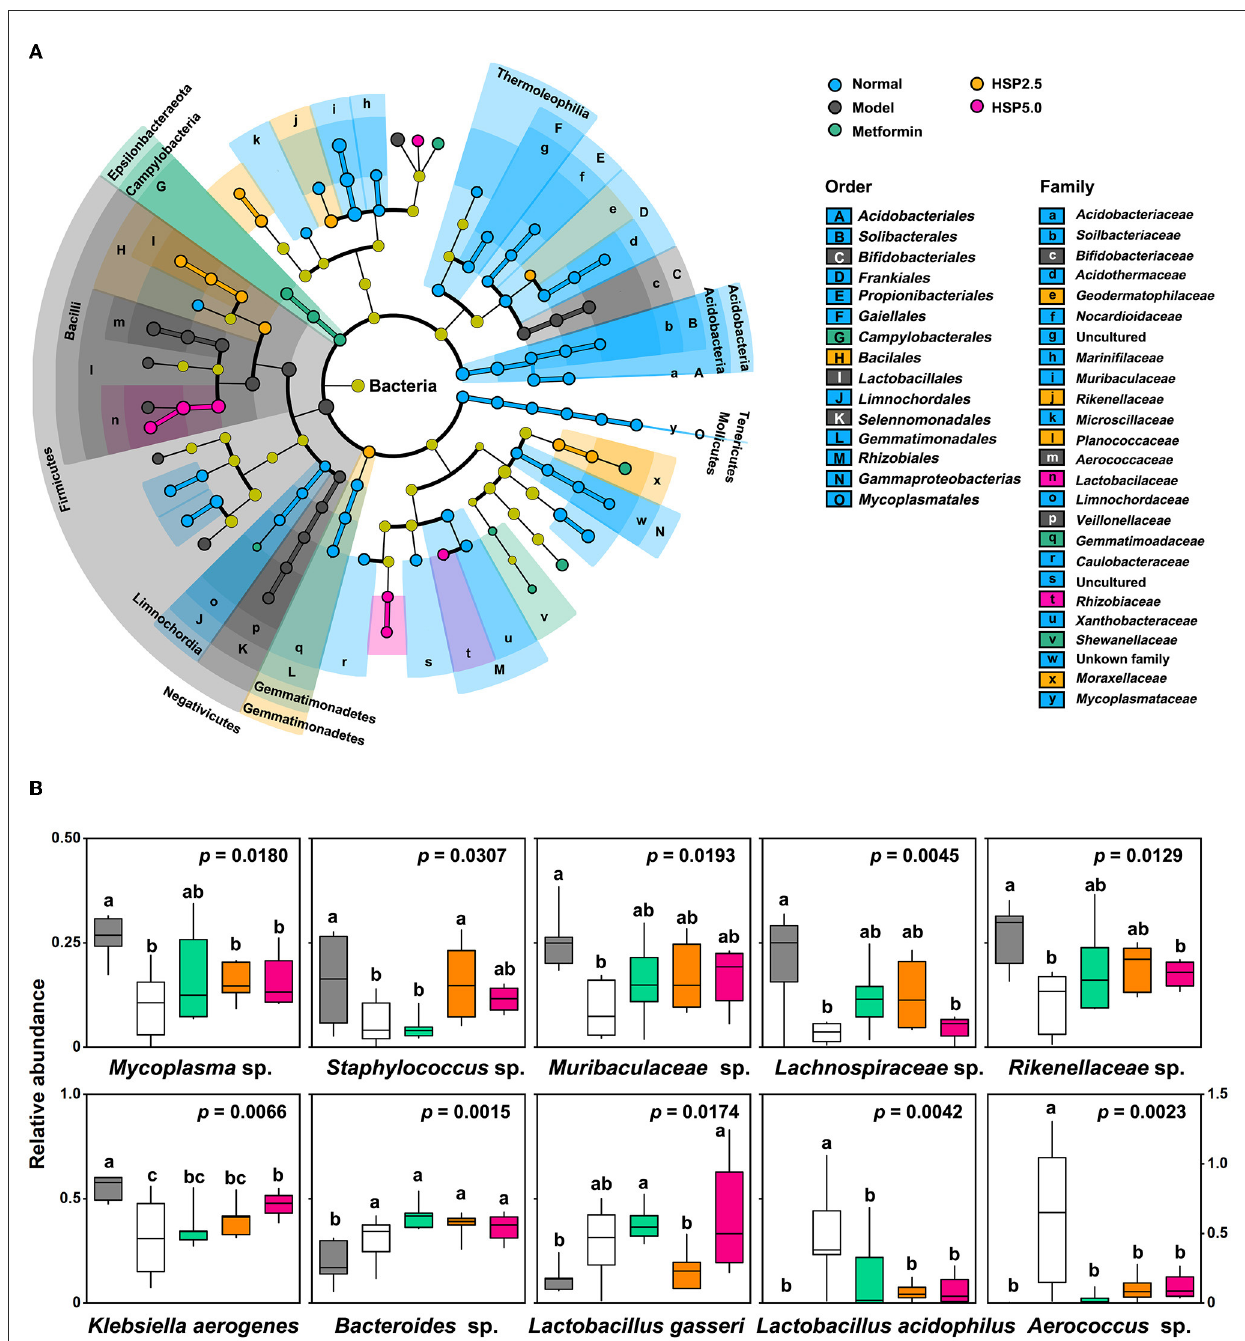
FIGURE3 Taxa associated with an HSP-augmented diet. (A) LEfSe analysis. The analysis was performed using P = 0.05 and a logarithmic LDA score of 3.0. (B) Relative abundances of the top 10 most significant OTUs. Relative abundances are presented as log 10 (100 × value + 1), and the P -values were adopted from ANOVA. Duncan’s multiple range test is denoted by “a”, “b”, and ‘c’ ( P = 0.05).